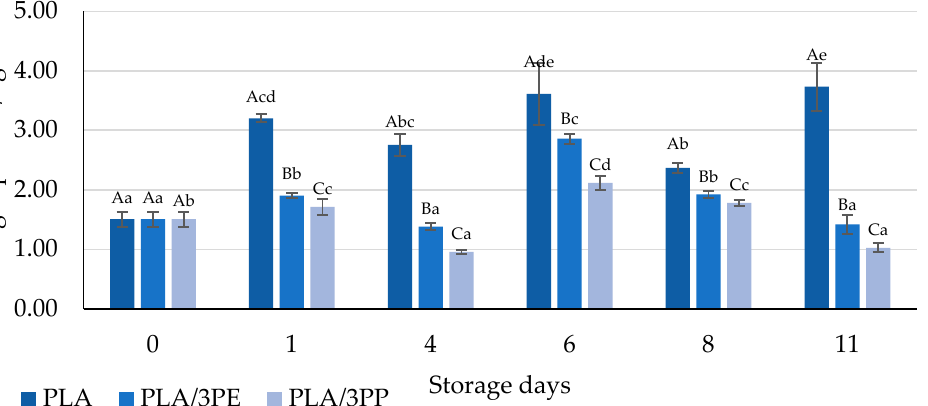
Figure 6. Results of the TBARS assay of the beef meat packaged with the control (PLA) and the active (PLA/3PPE and PLA/3PP) films. The uppercase letters compare the same packaging for different storage days. Different letters, for either lowercase/uppercase comparison, represent results with significant differences.